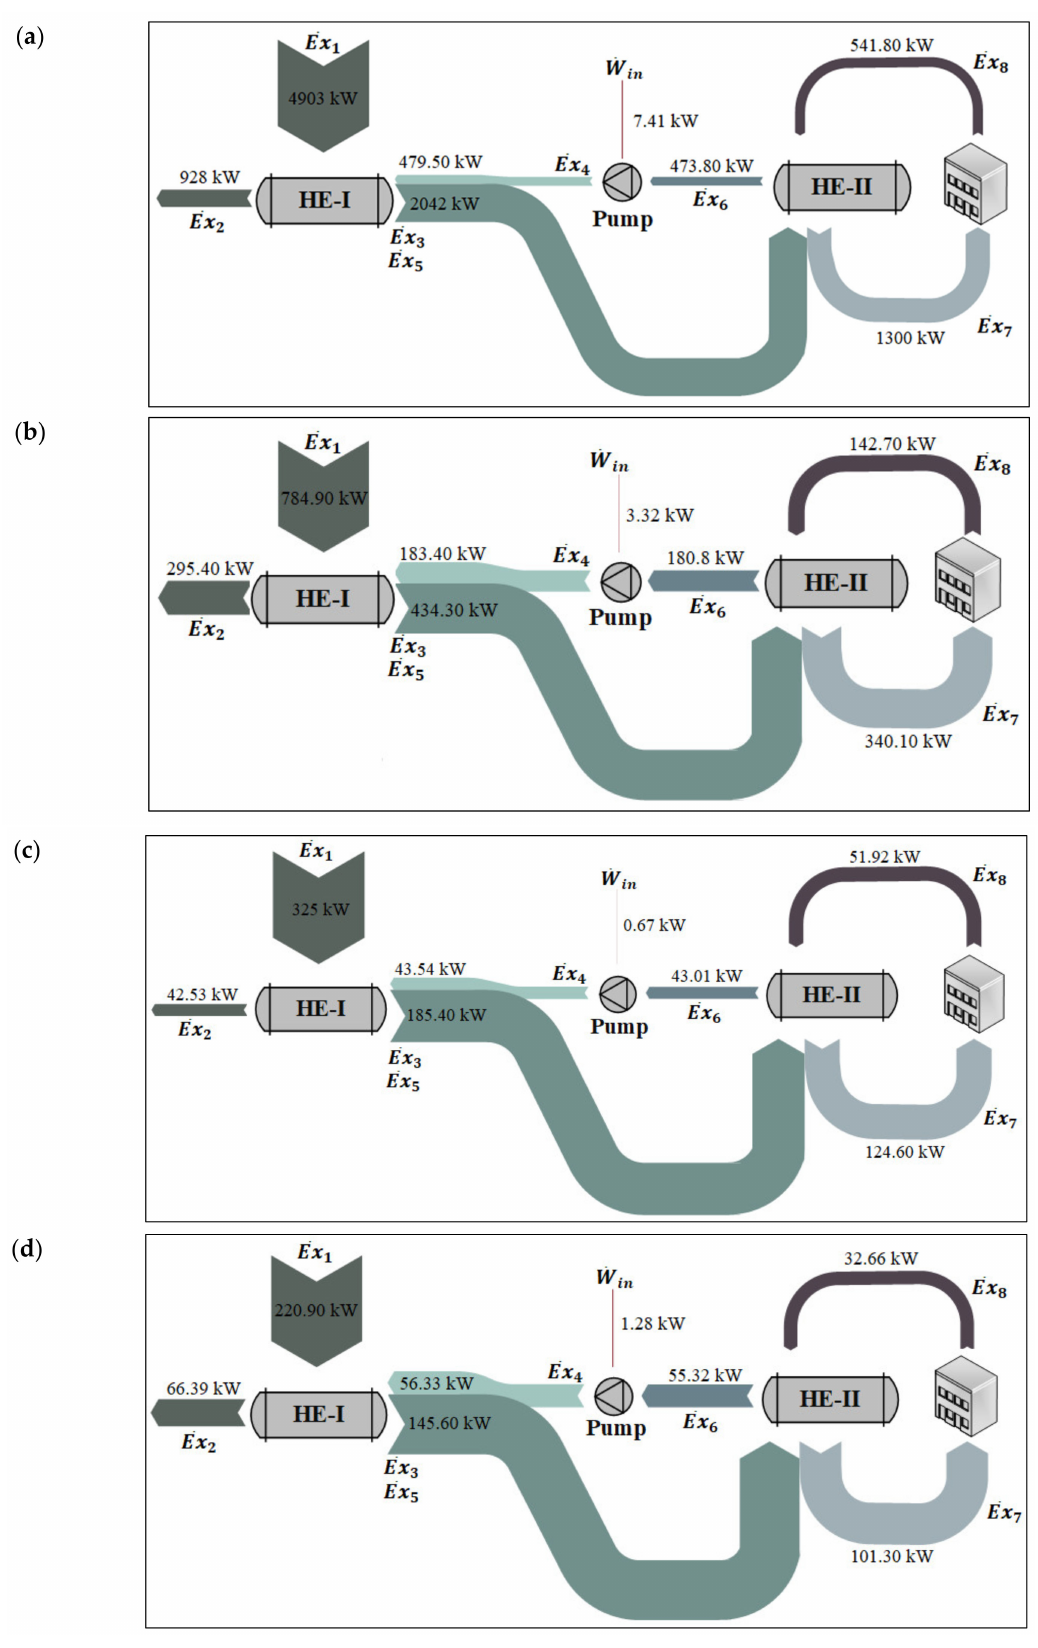
Figure 3. Grassmann (exergy flow) diagram of the created cases, ( a ) case one, ( b ) case two, ( c ) case three and ( d ) case